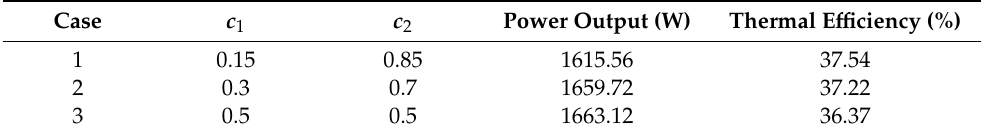
Table 7. E ff ects of weighting coe ffi cient on the optimal design’s performance.